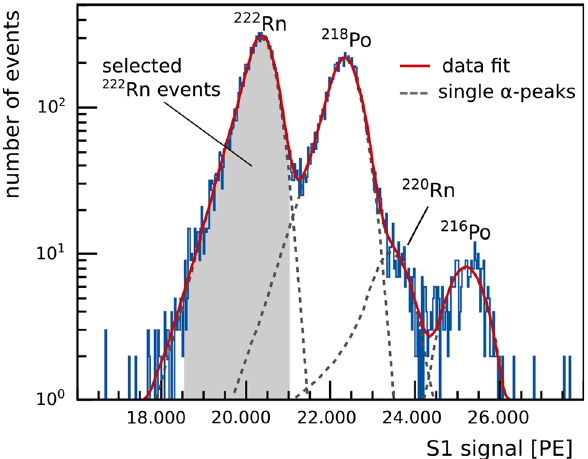
Fig. 3 222 Rn decays are selected in XENON100 data by a cut applied to the primary scintillation light signal S1 ( shaded region